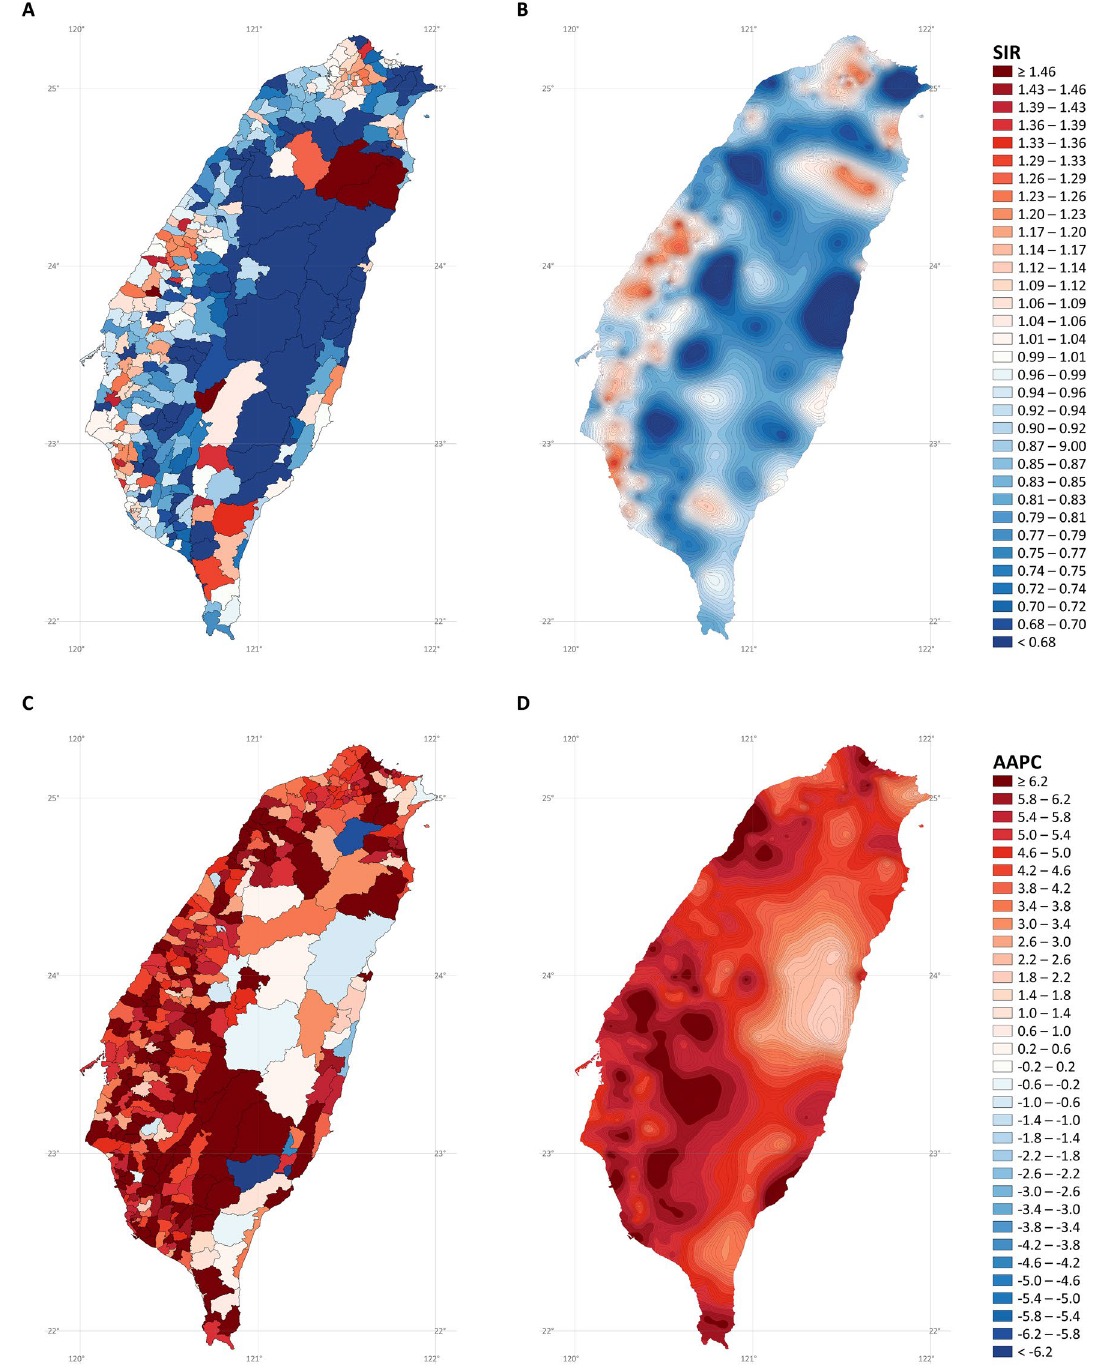
Figure 7. Maps of lung adenocarcinoma cancer in females ( A) standardized incidence ratios; ( B) stabilized kriged standardized incidence ratios; ( C) average annual percent changes; ( D) stabilized kriged average annual percent changes). The map was created by R version 3.5.2 with the ggplot2 package (https:// cran.r- proje ct. org/ web/ packa ges/ ggplo t2/ index. more recent birth cohorts. The finding contrasts those in the United States, Australia, and Denmark, where the incidence rates of lung adenocarcinoma increased only slowly or started to decline in recent birth cohorts 29,30 . The geographic distributions of lung adenocarcinoma incidence rates in Taiwan were similar for men and women. SIR hotspots were found mainly in the northern, western, and southern coastal cities, northeastern coastal towns, and eastern and southern cities and mountainous areas of Taiwan. Studies have found a dose–response relationship between air pollution and lung adenocarcinoma incidence rates 31–36 . The SIR hotspots of lung adenocarcinoma in Taiwan were correlated with the geographic distribution of air pollutants (including < 2.5- and < 10-μm particulate